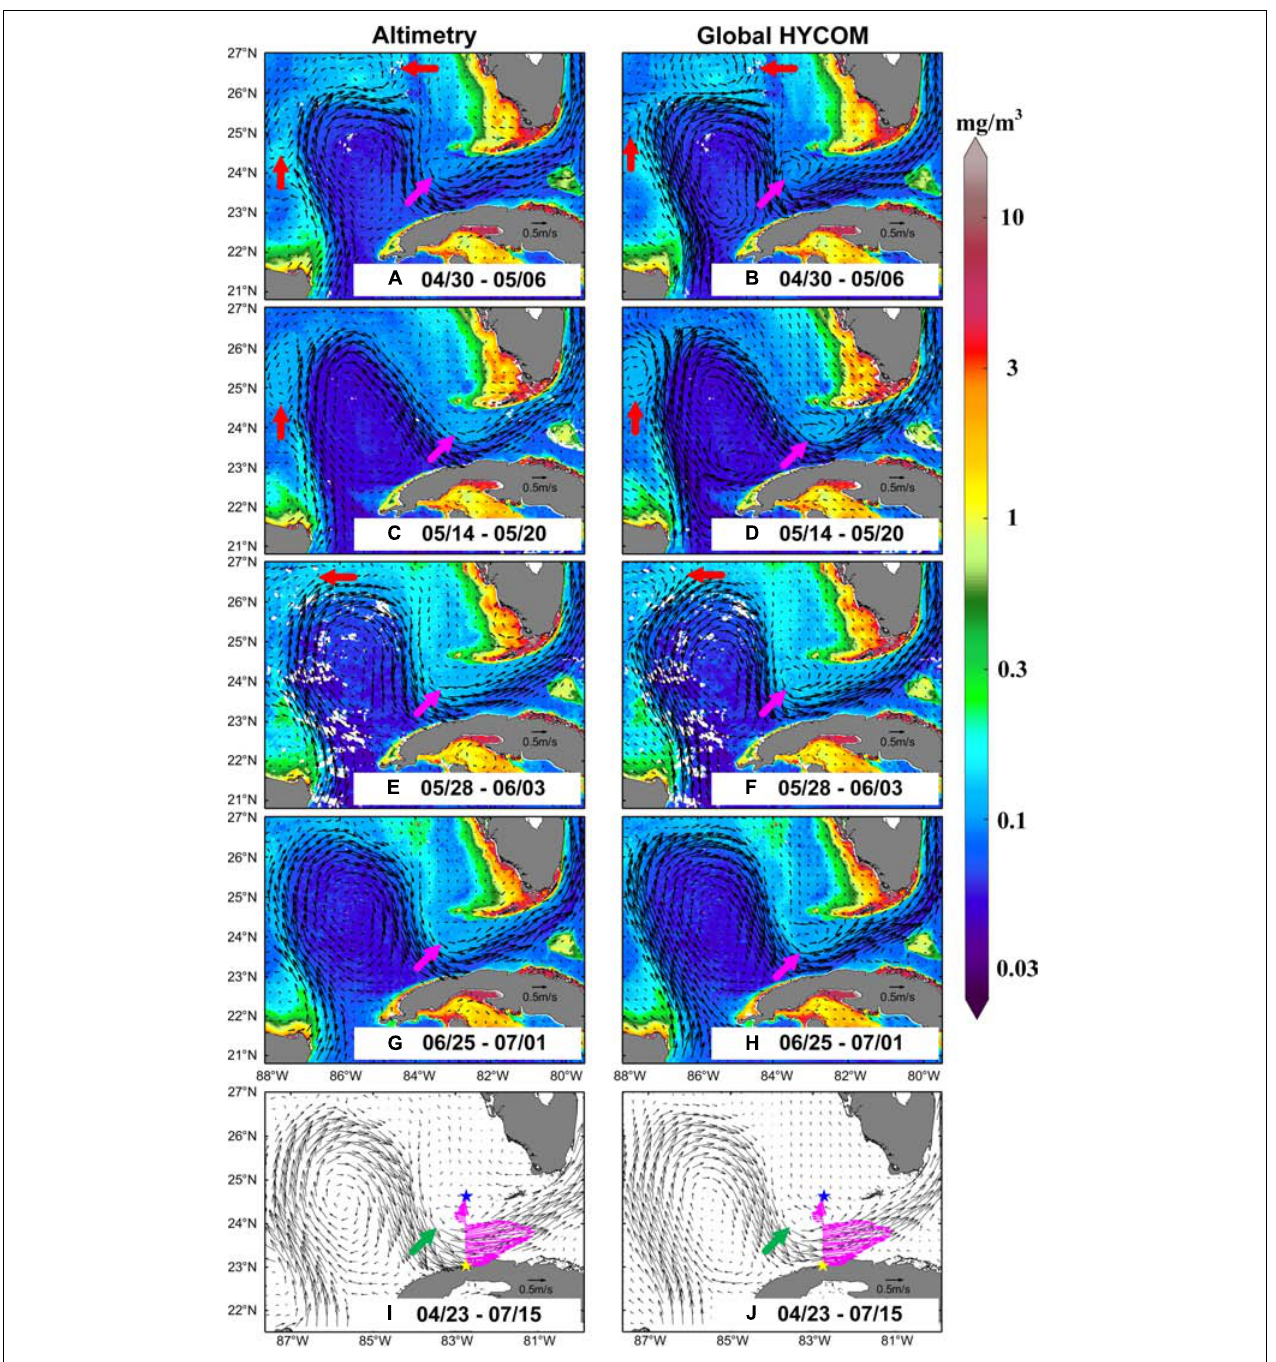
FIGURE 2 | Comparison of surface current distributions from altimetry observations (left column) and global HYCOM simulations (right column). The color codes in (A–H) indicate MODIS/A Chl distributions. The location of the CE off the DT is annotated with a thick magenta and green arrow in (A–H) and (I,J) , respectively. The locations of several LC frontal eddies are annotated with thick red arrows in (A–F) . The currents (thin magenta vectors, vertically averaged over the layer of ∼ 5–10 m) measured by shipborne ADCP on May 24 and 25, 2017 are overlaid in (I,J) for altimetry and global HYCOM, respectively. The yellow and blue pentagrams in (I,J) denote the start and end points of the ship’s